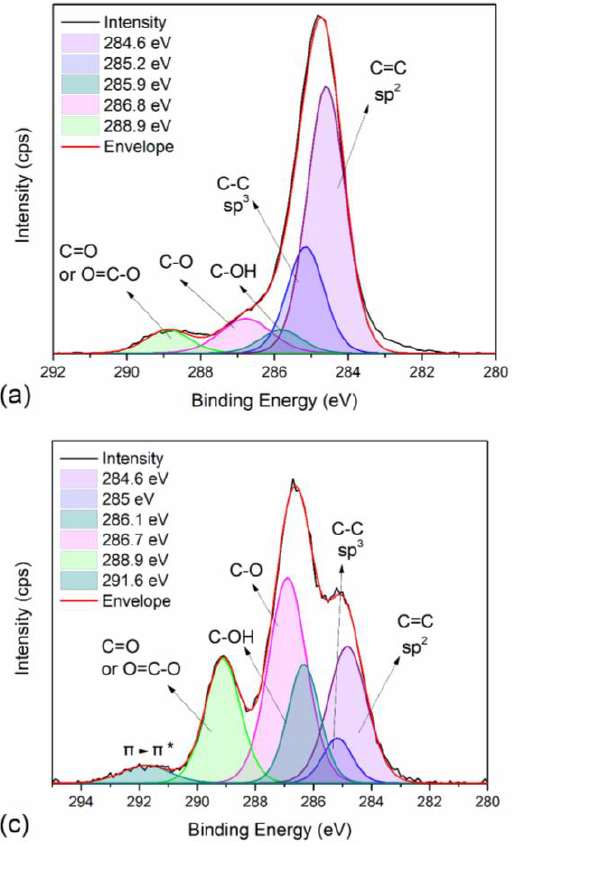
Figure 4. XPS spectra and peak deconvolution centered on the C1s orbital range of ( a ) neat PEF (R 2 = 0.997), ( b ) PEF/1 GNPs (R 2 = 0.996), ( c ) PEF/1 CNTs (R 2 = 0.998), and ( d ) PEF/0.25 GNPs/1 CNTs (R 2 = 0.997).